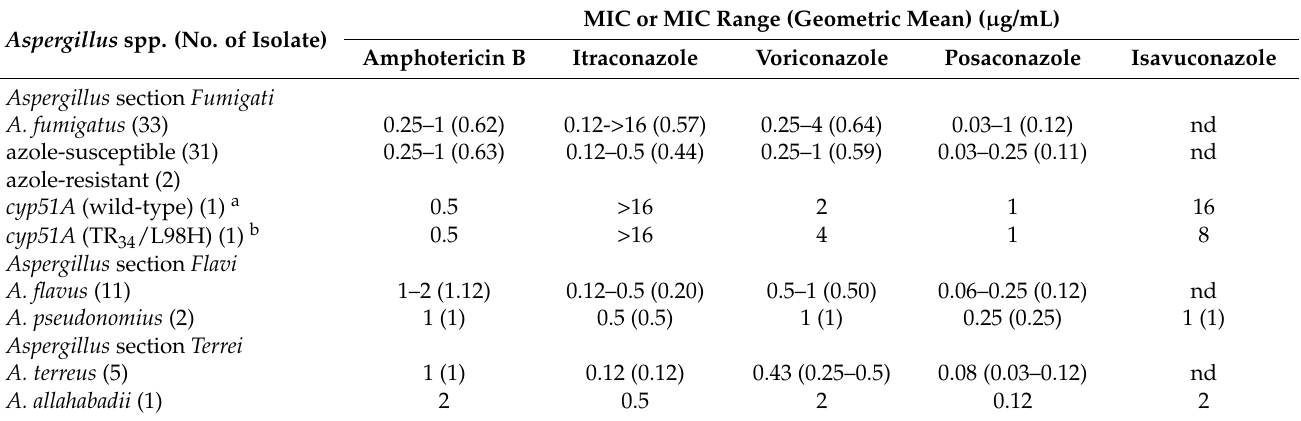
Table 3. Antifungal susceptibility profiles of 52 Aspergillus isolates determined by CLSI